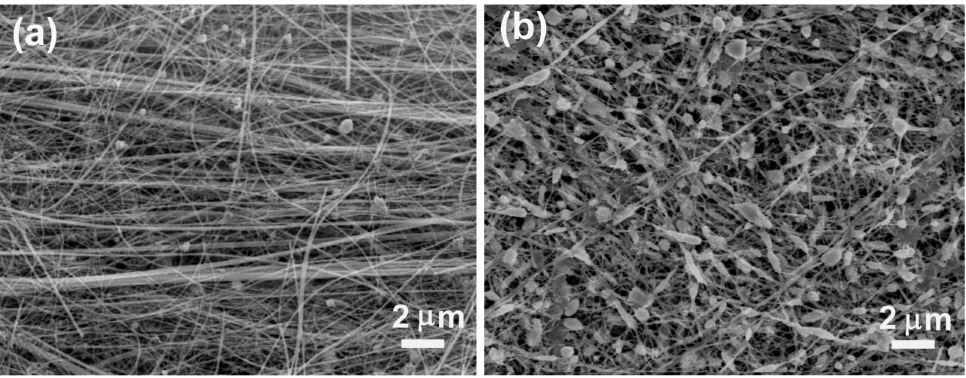
Figure 6. SEM images of the self-supported nanowire electrode (SNWE) prepared by thermal annealing of CuNW bundles at different temperatures: ( a ) 300 ◦ C and ( b ) 400 ◦ C.